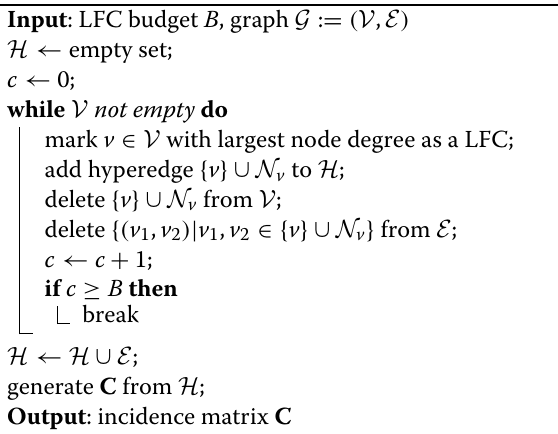
Algorithm 2: Greedy Selection of